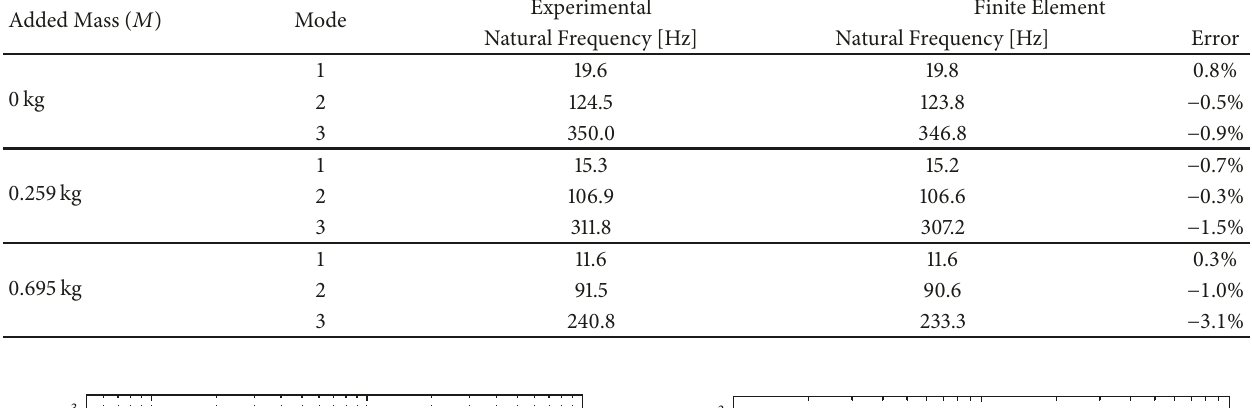
Table 1: Finite element and experimental natural frequencies for the DROPBEAR with no added mass ( 𝑀 = 0 kg), adding the electromagnet near the beam tip ( 𝑀 = 0.259kg), and with the electromagnet and added mass plates ( 𝑀 = 0.695 kg). Percent errors are relative to the experimentally obtained natural frequencies.